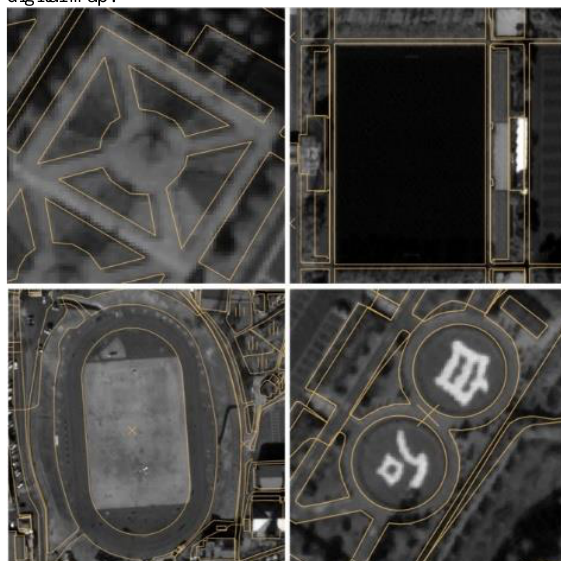
Figure 9. Enlarged Chungcheongnamdo orthoimage with overlaid digital